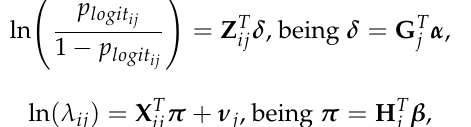
Overdispersion in Outcome Variable Inflation of Zeros in Outcome